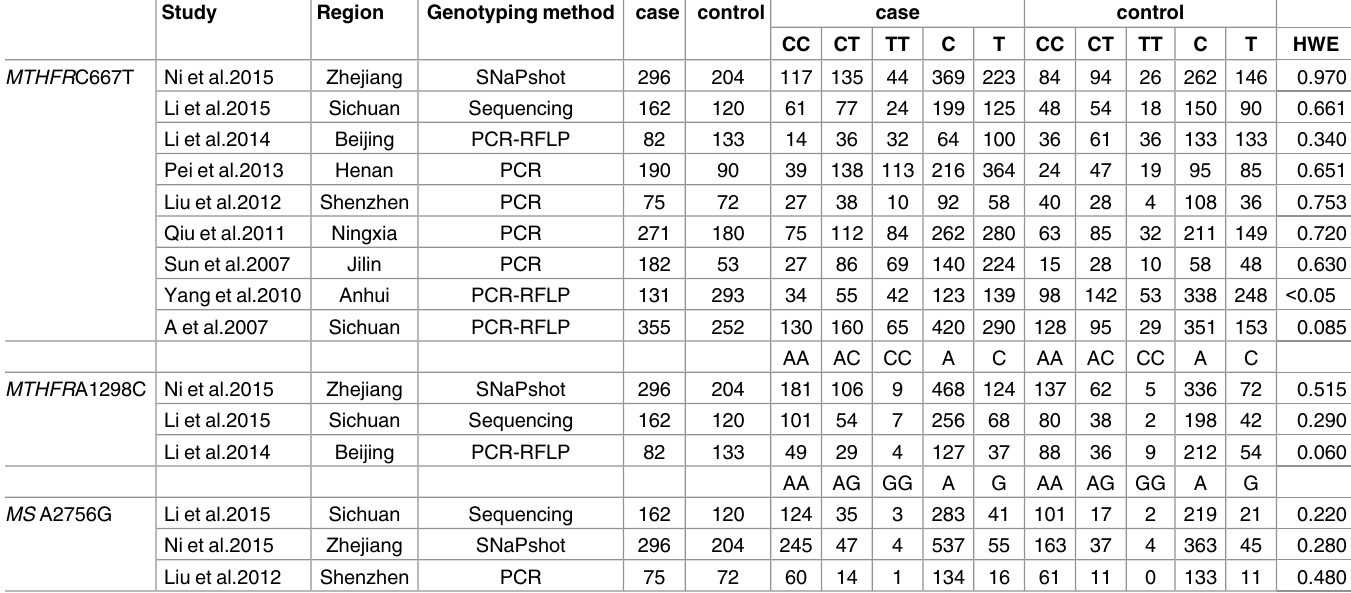
Table 1. Characteristics of the studies included in the meta-analysis and their genotype distributions of the MTHFR C677T, MTHFR A1298Cand MS A2756Ggene polymorphisms.